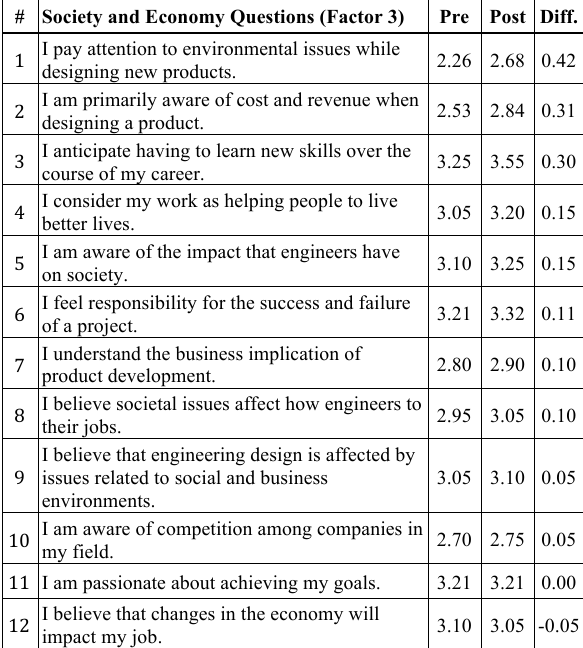
TABLE IV. I TEM S CORES FOR S OCIETY AND E